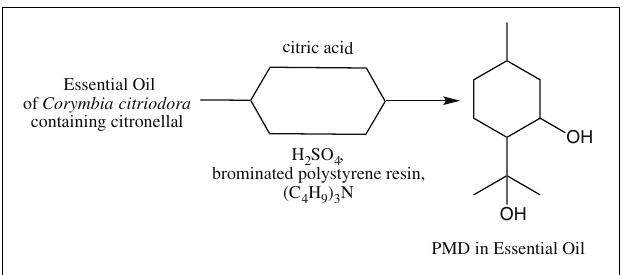
FIGURE 7 | Syntheses of PMD directly from EO of Corymbia citriodora catalyzed by Lewis